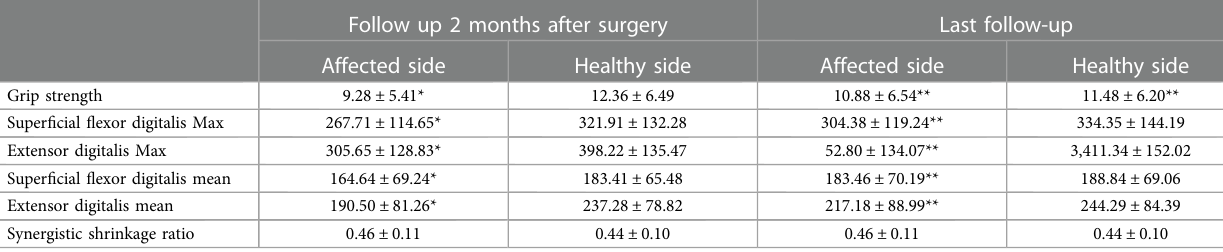
TABLE 1 The results of grip strength (kg) on the affected side and the healthy side, the maximum value of electromyographic RMS (µV), the mean value of RMS (µV), and the synergistic shrinkage ratio of the super fi cial fl exor and digital extensor muscles during gripping with the grip meter 2 months after the operation and the last follow-up.